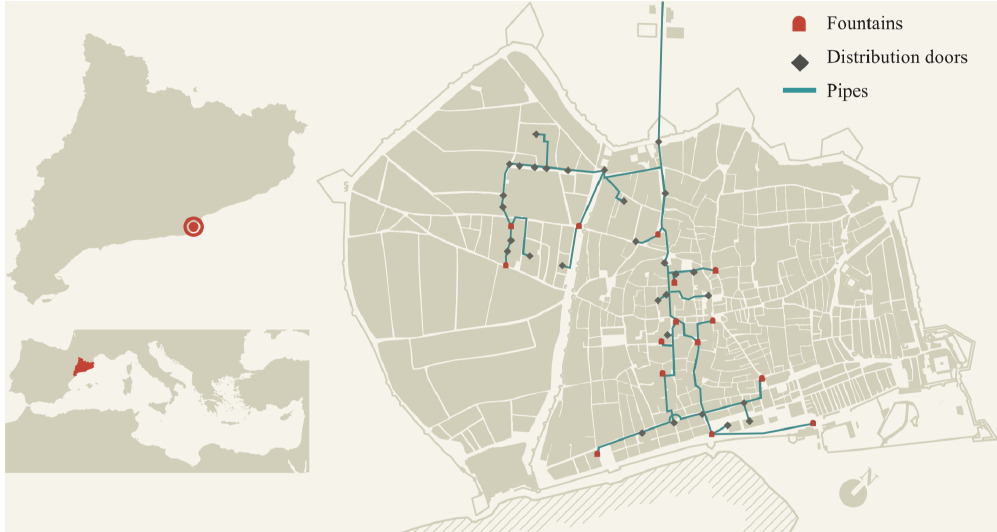
Figure 9. The urban water supply network of Barcelona as described in the Llibre de les Fonts . Source: Guàrdia (2011), modified by the present